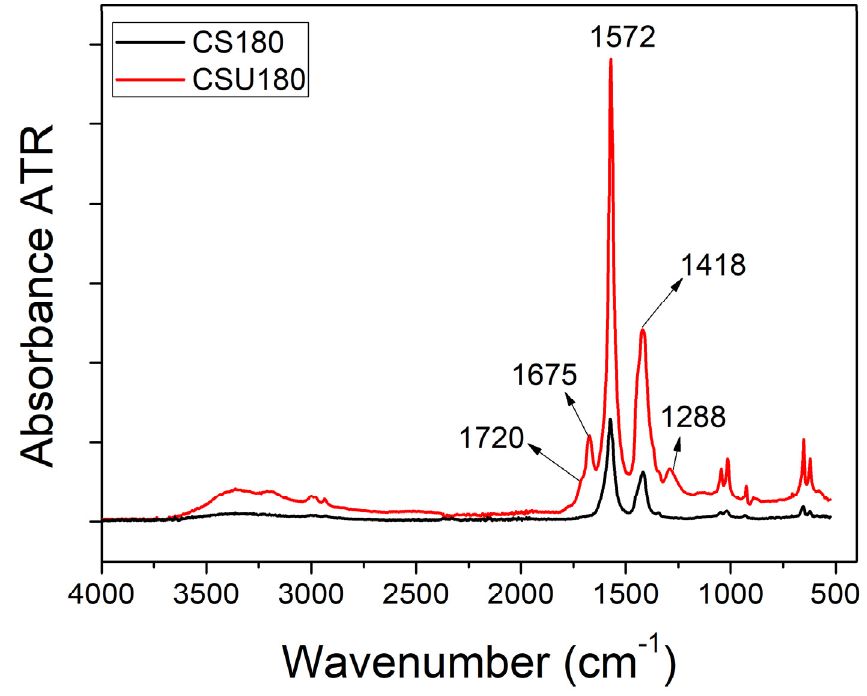
Figure 1. FTIR spectra of CS180 (marked in black) and CSU180 (marked in red). The surface functional groups generated on the CNDs surface by the hydrothermal carbonization of chitosan precursor were analyzed by high-resolution XPS (Figure 2). As